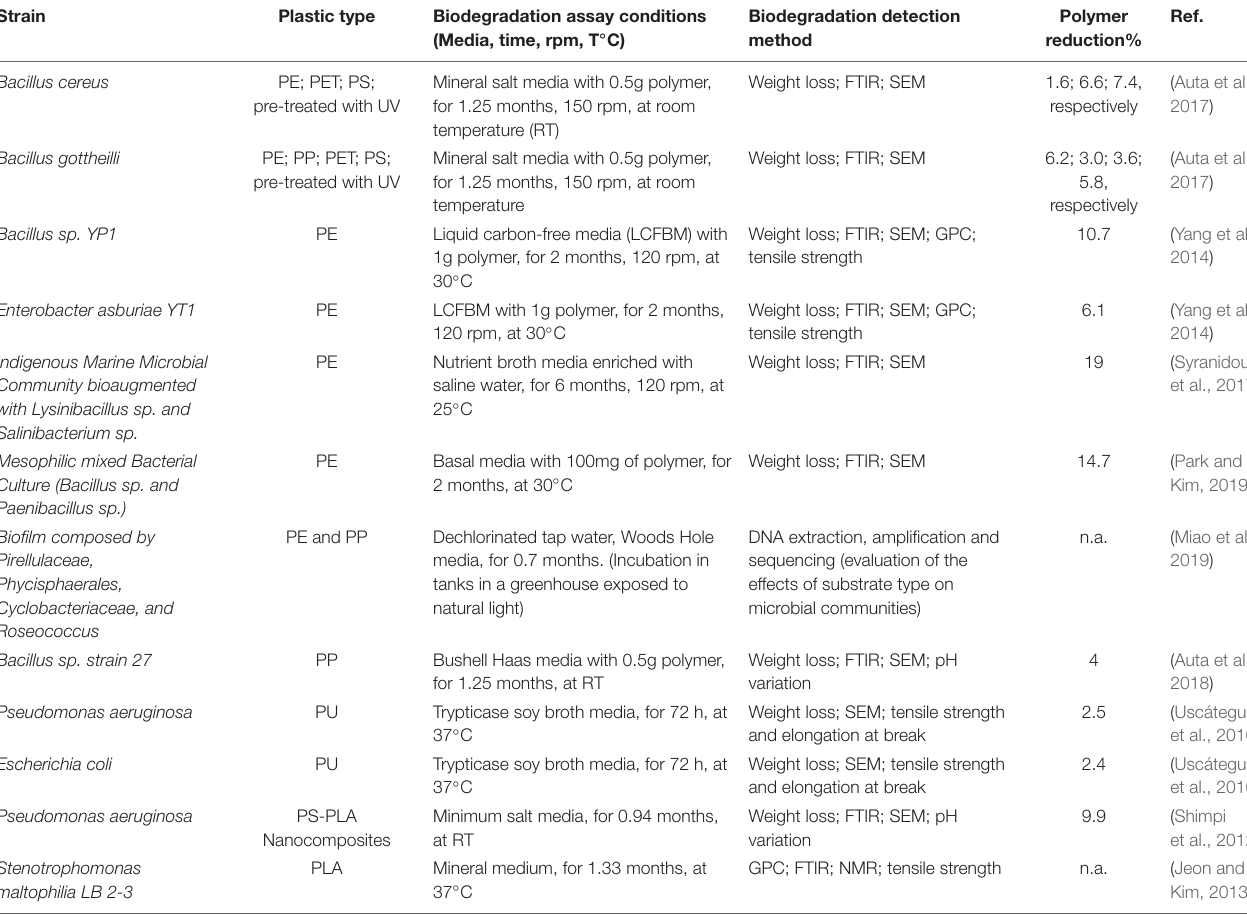
TABLE 2 | Plastics degraded by microorganisms, biodegradation assay conditions, and used detection